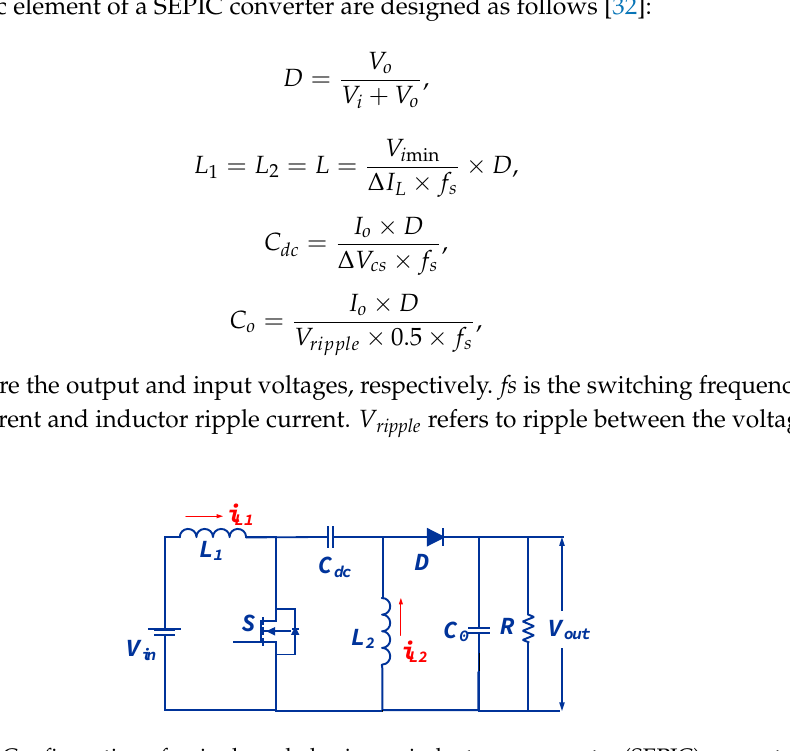
V out Figure 5. Configuration of Boost converter. 4.2. SEPIC Converter SEPIC converter is a category of the buck ‐ boost converter, which follows both the boost and